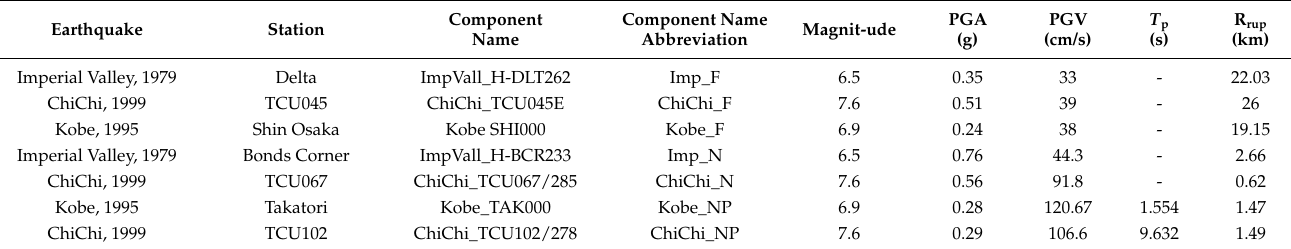
Figure 4. Acceleration response spectrum. Table 4. Ground